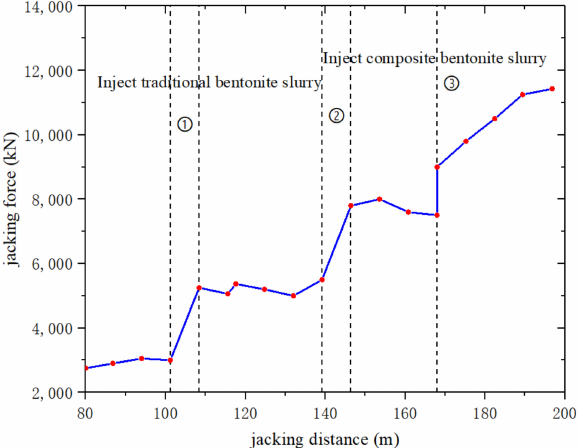
Figure 1. Jacking force–jacking distance